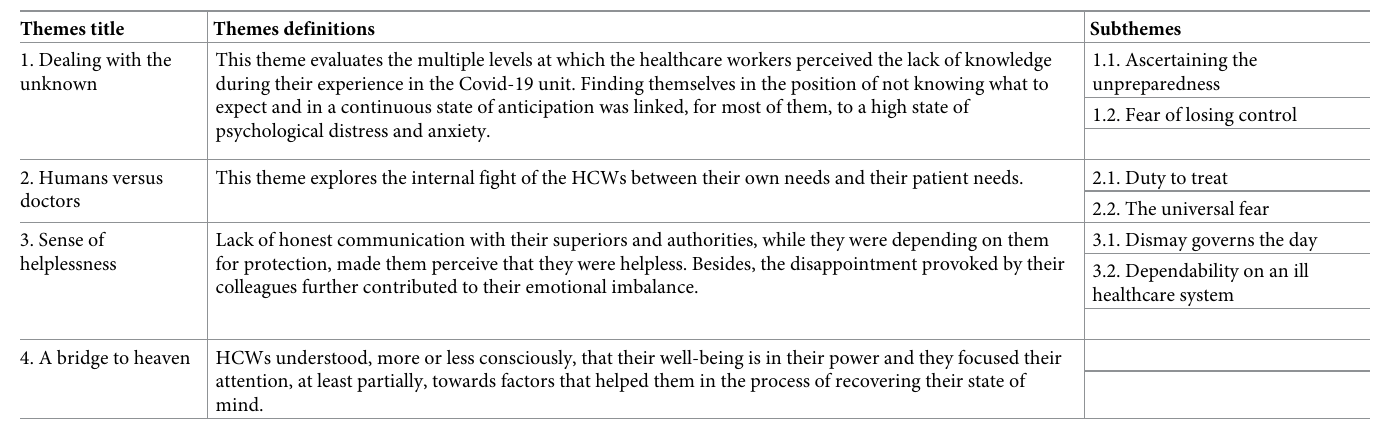
Table 3. Overview of